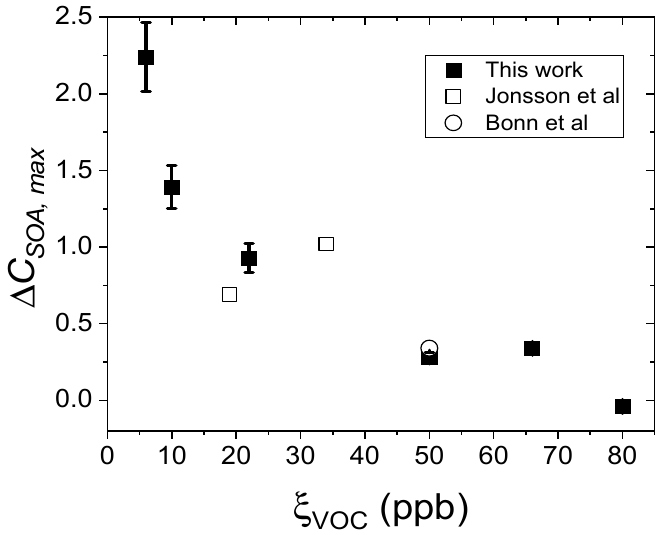
Figure 4. Change in dry SOA mass formed by ozonolysis of α -pinene at different ξ VOC . Δ N = − 1 for the case of complete shutdown of SOA formation and Δ N = 0 for no change. Error bars indicate one standard deviation for n = 4. The literature values are inferred from Jonsson et al. [12,25] and Bonn et al. [21].